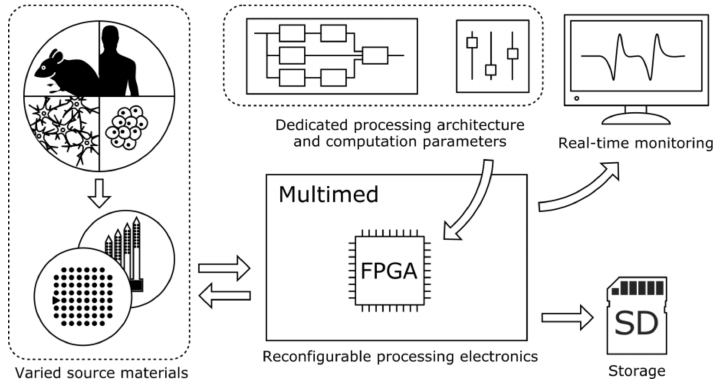
Figure 1. Multimed and its interfaces. From left to right: User parameters are fed into the system, which is connected to the measured and/or stimulated cell culture. The board then processes the data using a Field Programmable Gate Array (FPGA), which displays measurements on an external screen and records unprocessed and processed data to SD